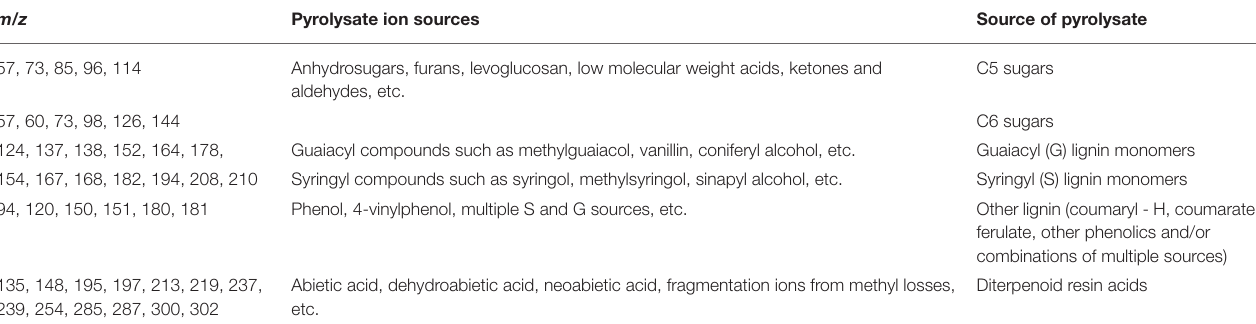
TABLE 2 | Summary of ion assignments in py-MBMS spectra of lignocellulosic biomass or biomass extracts.